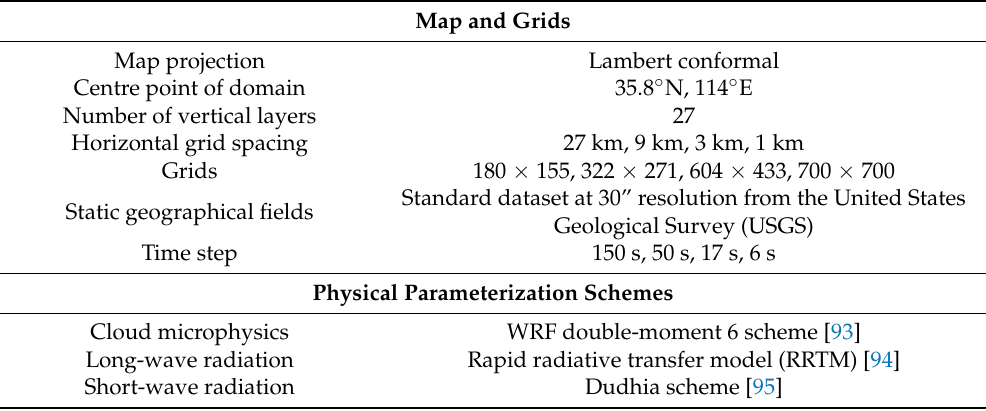
Table 1. The main configuration of the WRF